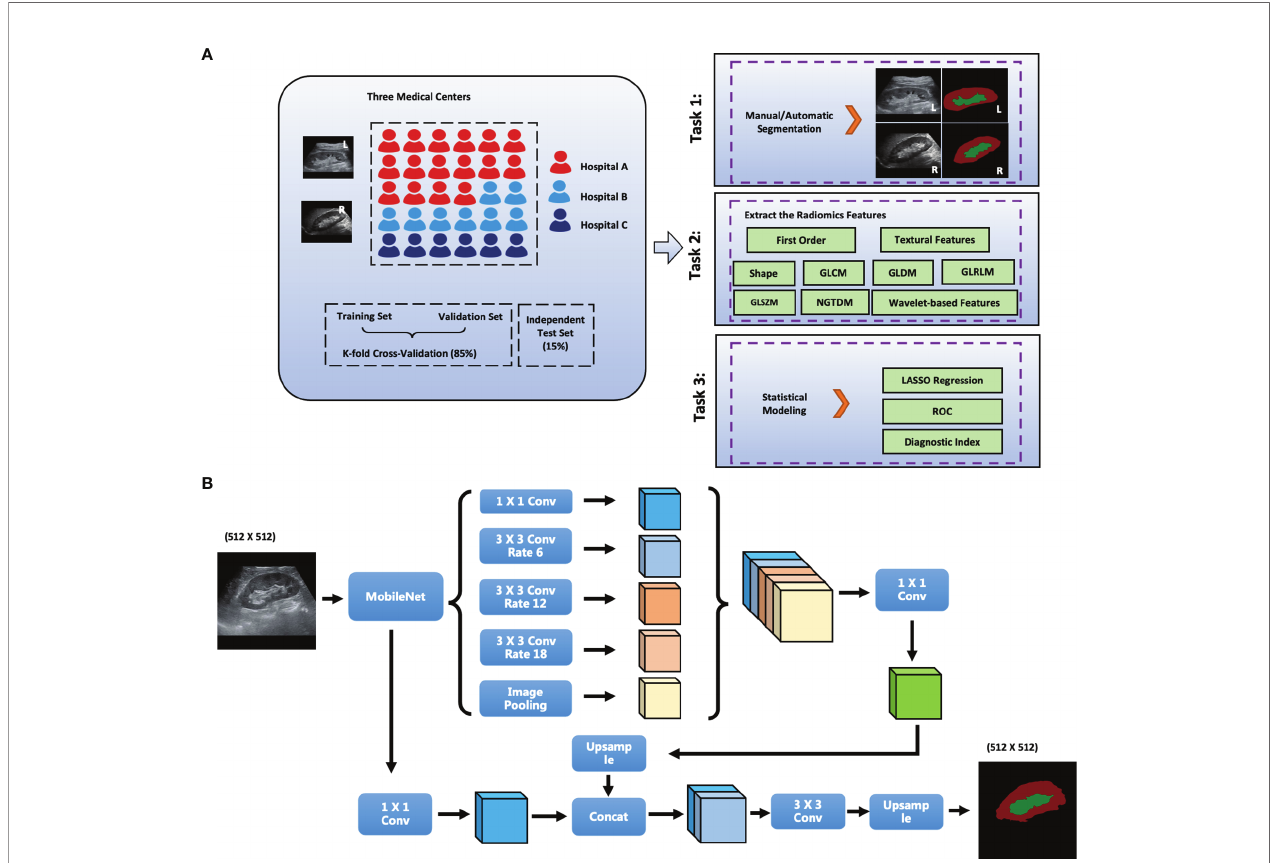
FIGURE 1 | The scheme of this study. (A) Flowchart of the Study; (B) Network Structure of DeepLabV3+; L, left; R, right; GLCM, gray level co-occurrence matrix; GLRLM, gray level run length matrix; GLSZM, gray level size zone matrix; First_order, fi rst order statistics; NGTDM, neighboring gray tone difference matrix; GLDM, gray level dependence matrix. Conv: Convolution layer; Hospital A: The Second Af fi liated Hospital of Zhejiang University School of Medicine, SAHZU; Hospital B: Tianjin Third Central Hospital, THTCH; Hospital C: The People ’ s Hospital of Yingshang,